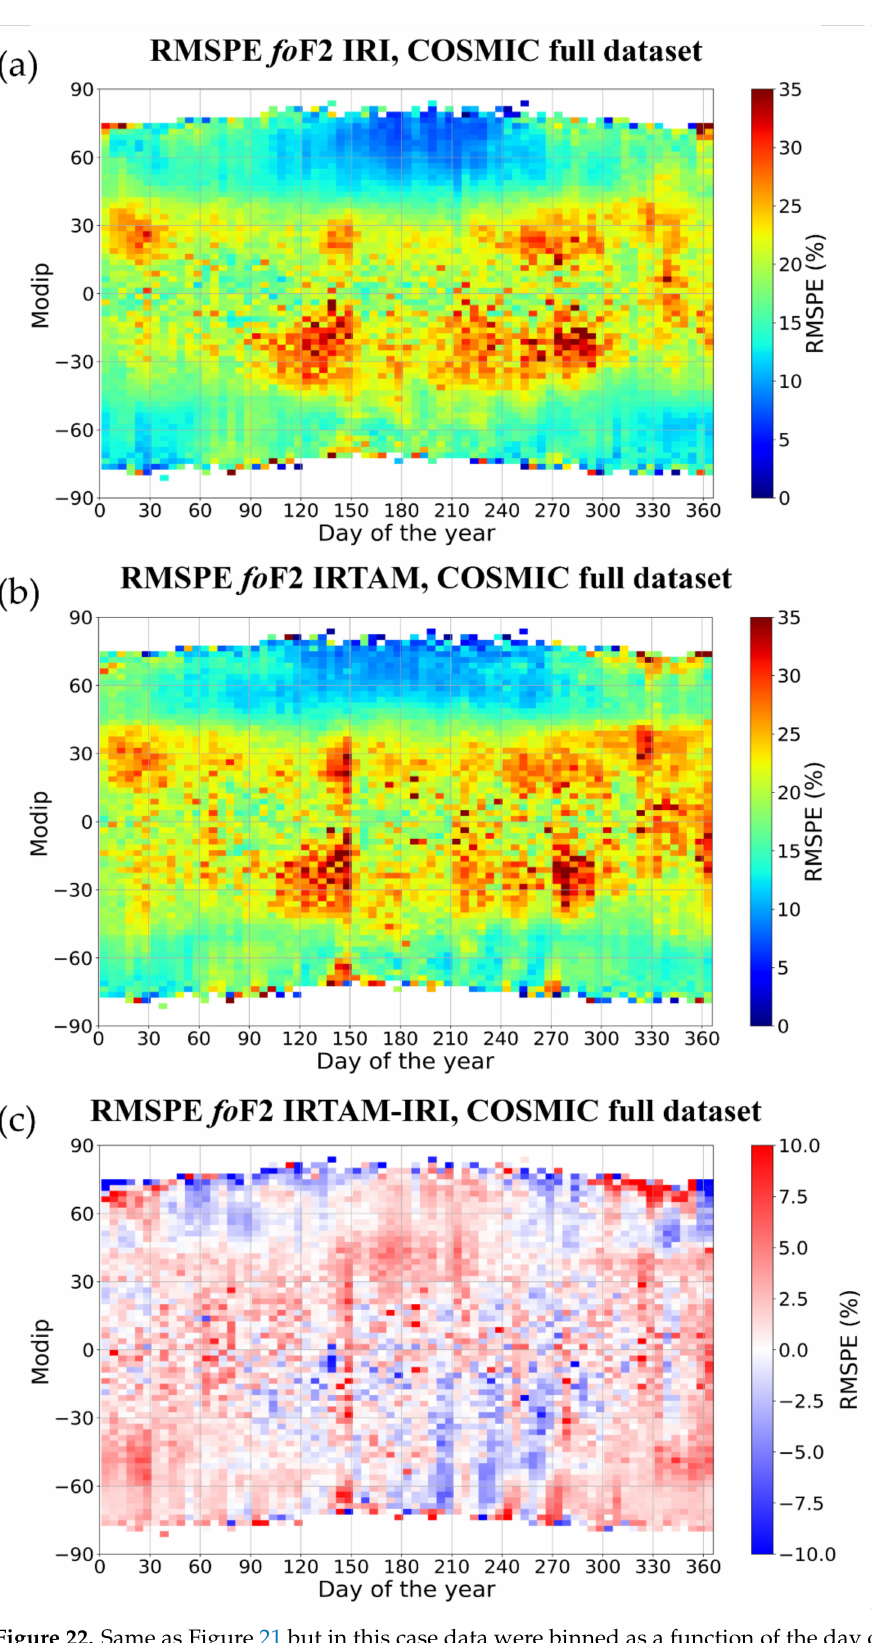
Figure 22. Same as Figure 21 but in this case data were binned as a function of the day of the year (five-day wide bins) and modip (2.5 ◦ -wide